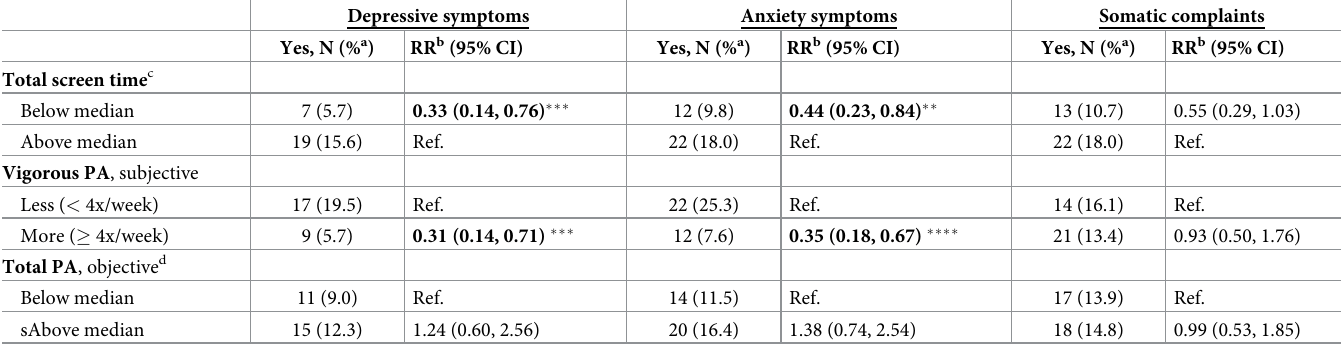
Table 2. Associations of screen time and physical activity with symptoms of depression, anxiety and somatic complaints. Depressive symptoms Anxiety symptoms Somatic